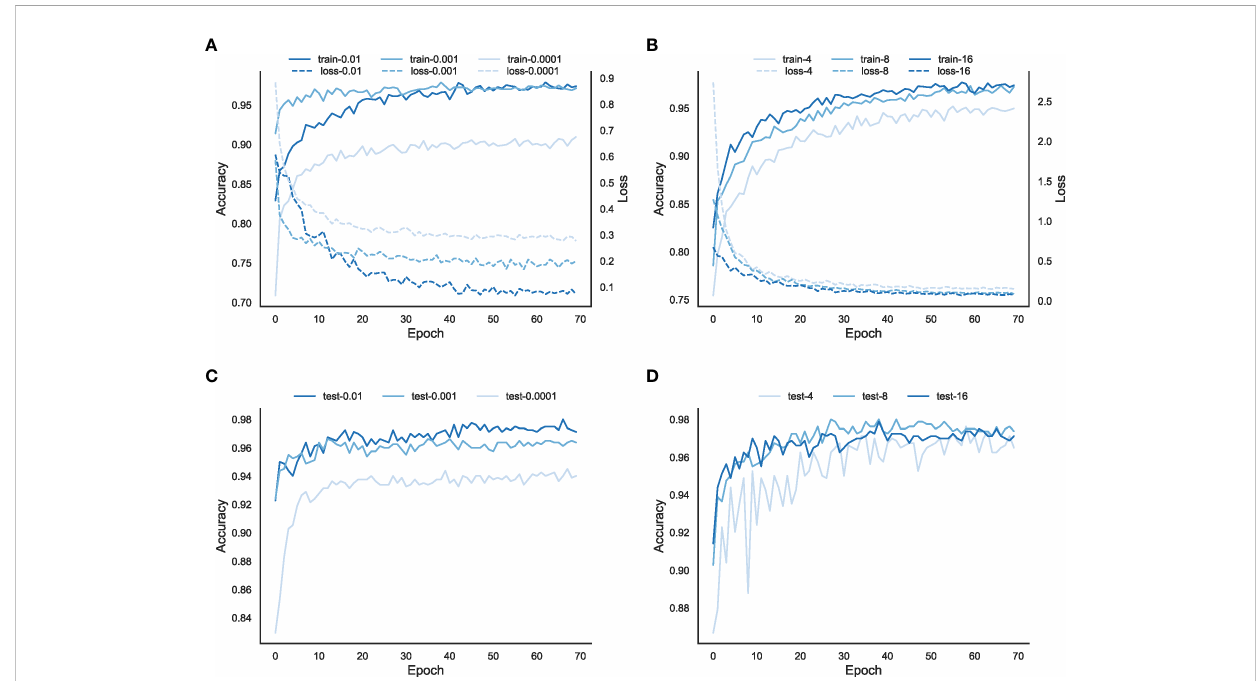
FIGURE 2 Parameter optimization of the model EchoAI with different learning rates and batch sizes. (A) is the loss and accuracy of the model in the training set for different learning rates; (B) is the accuracy of the model in the validation set for different learning rates; (C) is the loss and accuracy of the model in the training set for different batch sizes; and (D) is the accuracy of the model in the validation set for different batch